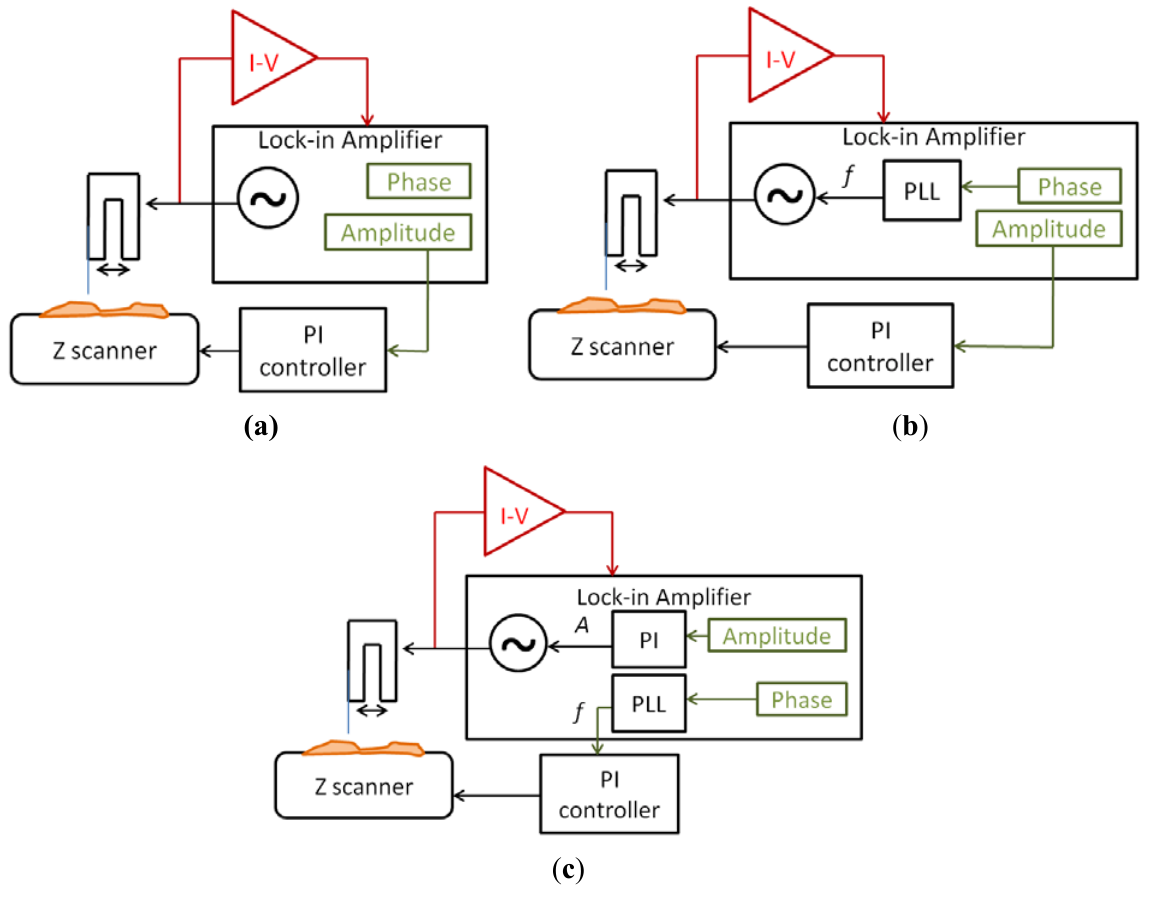
Figure 7. ( a ) Scheme of the amplitude modulation mode; ( b ) Amplitude modulation with a PLL to track the resonant frequency; ( c ) Scheme of the frequency modulation